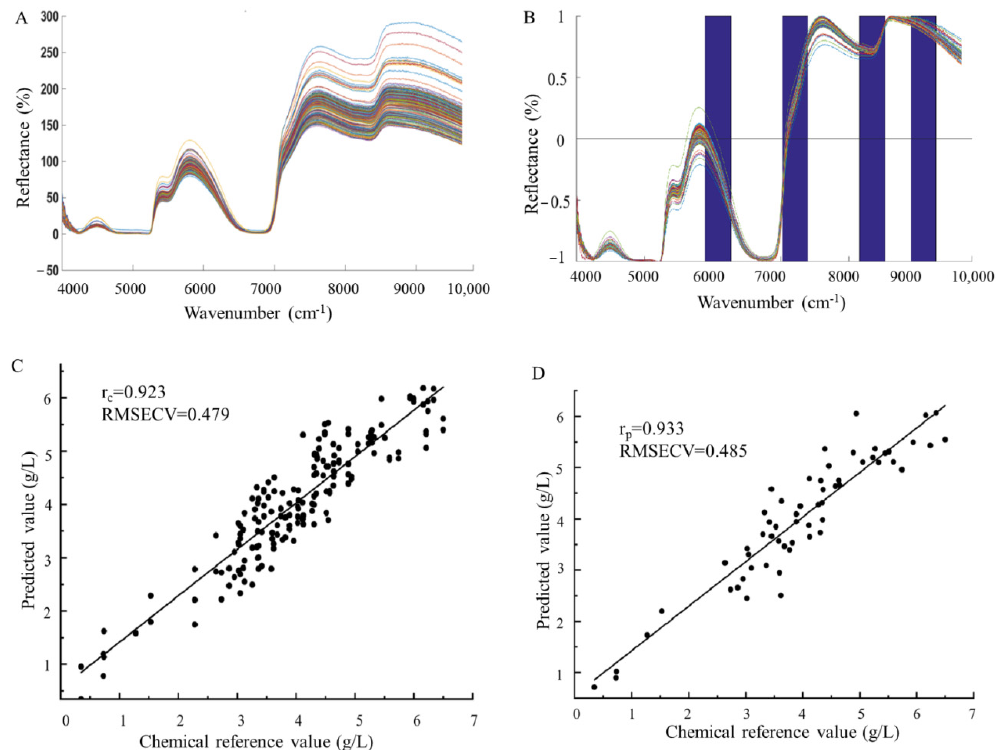
Figure 2. Near Infrared Spectroscopy (NIRS) acquisition and model construction of gellan gum yield. ( A ) Original spectrogram; ( B ) Best subinterval; ( C ) Training set; and ( D ) Prediction set. Table 1. Gellan gum yield of S. paucimobilis ATCC 31461 and its mutant strains at different fer ‐ mentation time determined by physical and chemical methods.